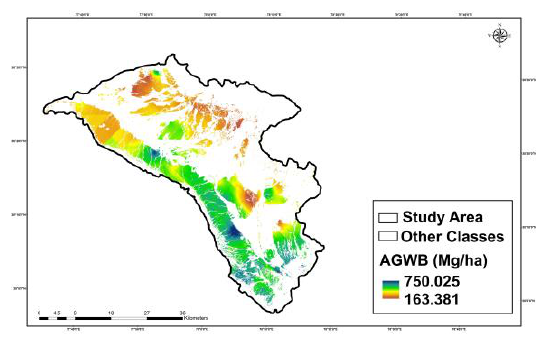
Figure 9. Aboveground Woody Biomass (AGWB) Prediction Map